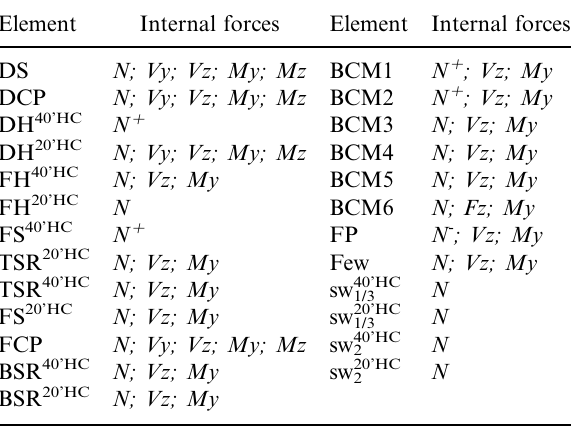
Table 7. Preponderant internal forces